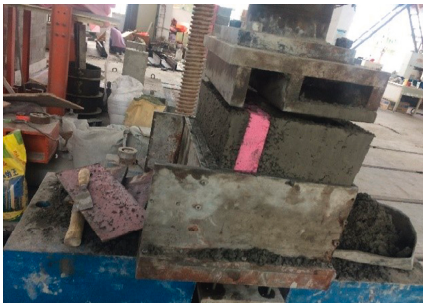
Figure 9: Block after the curing